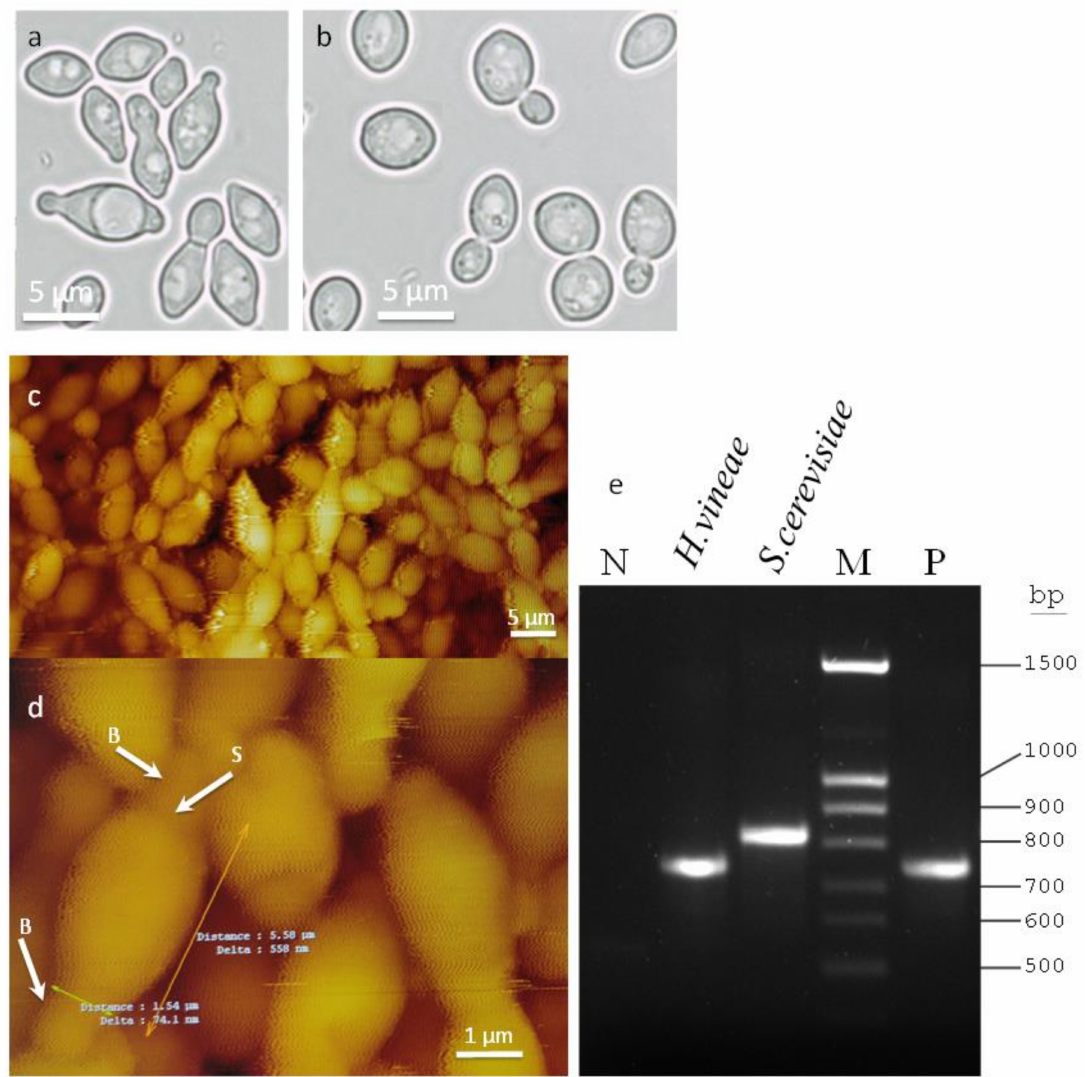
Figure 1. Optical microscopy of Hanseniaspora vineae ( a ) and Saccharomyces cerevisiae . ( b ) Atomic force microscopy (AFM) 3D topographic images of lyophilised cells of Hanseniaspora vineae with pseudocolour scale representation (dark areas represent lower height values while brighter areas represent higher height values). ( c ) A 50-micron scan size image showing typical apiculate morphology with a lemon-like shape and bipolar budding. ( d ) A 13.5-micron scan size image showing details of the cells. Thin arrows show typical dimensions of the cell and bud length. Thick white arrows labelled as “B” indicate the positions of the buds. The thick white arrow labelled as “S” indicates the position of the scar. ( e ) Agarose gel electrophoresis of a PCR product obtained from the amplification of the 5.8S-ITS (Internal Transcribed Spacer) region using the universal primers ITS1–ITS4 from S. cerevisiae and H. vineae ; M, molecular weight marker (100-bp DNA ladder). N: negative control without DNA in the PCR reaction; P: positive control with purified genomic DNA of Hanseniaspora as a